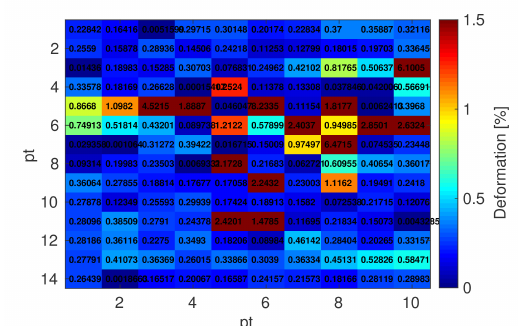
Figure 7. Full-field strain map of the sample 45 (bigger pellets).